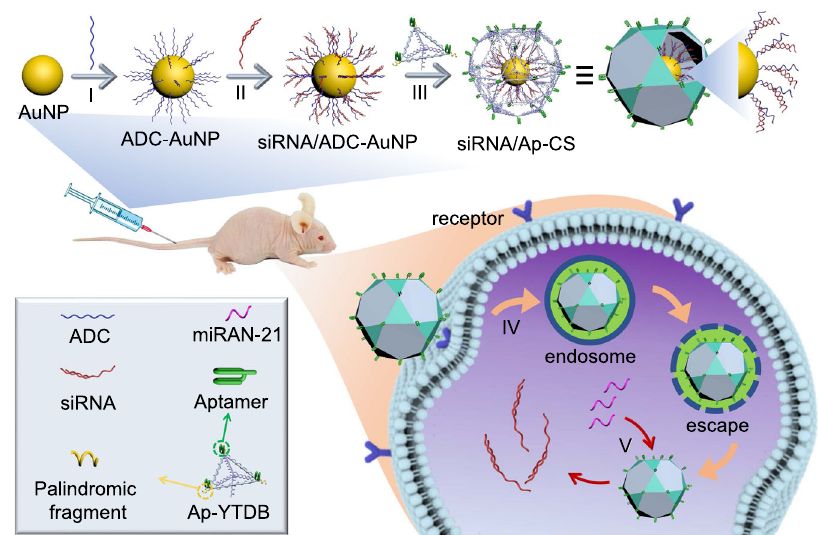
Fig. 1 Preparation of gold nanoparticle/multi-functional 3D DNA self-assembled multilayer core/shell nanostructure (siRNA/Ap-CS) and its application for targeted siRNA delivery and controlled release within tumor cells. Step I , functionalization of AuNP with thiol-modi fi ed anchoring DNA complementary to miRNA (ADC), forming ADC-AuNP; Step II , binding of elongated siRNA to AuNP-con fi ned ADC, producing siRNA/ADC-AuNP; Step III , programmed positioning of aptamer (Ap)-integrated Y-shaped backbone-rigidi fi ed triangular DNA bricks (Ap-YTDB) onto siRNA/ADC-AuNP, leading to the formation of expected biocompatible core/shell nanostructure, siRNA/Ap-CS; Step IV , aptamer-mediated speci fi c cell recognition and endocytosis; Step V , intracellular controlled release of encapsulated siRNAs by the strand displacement initiated by endogenous